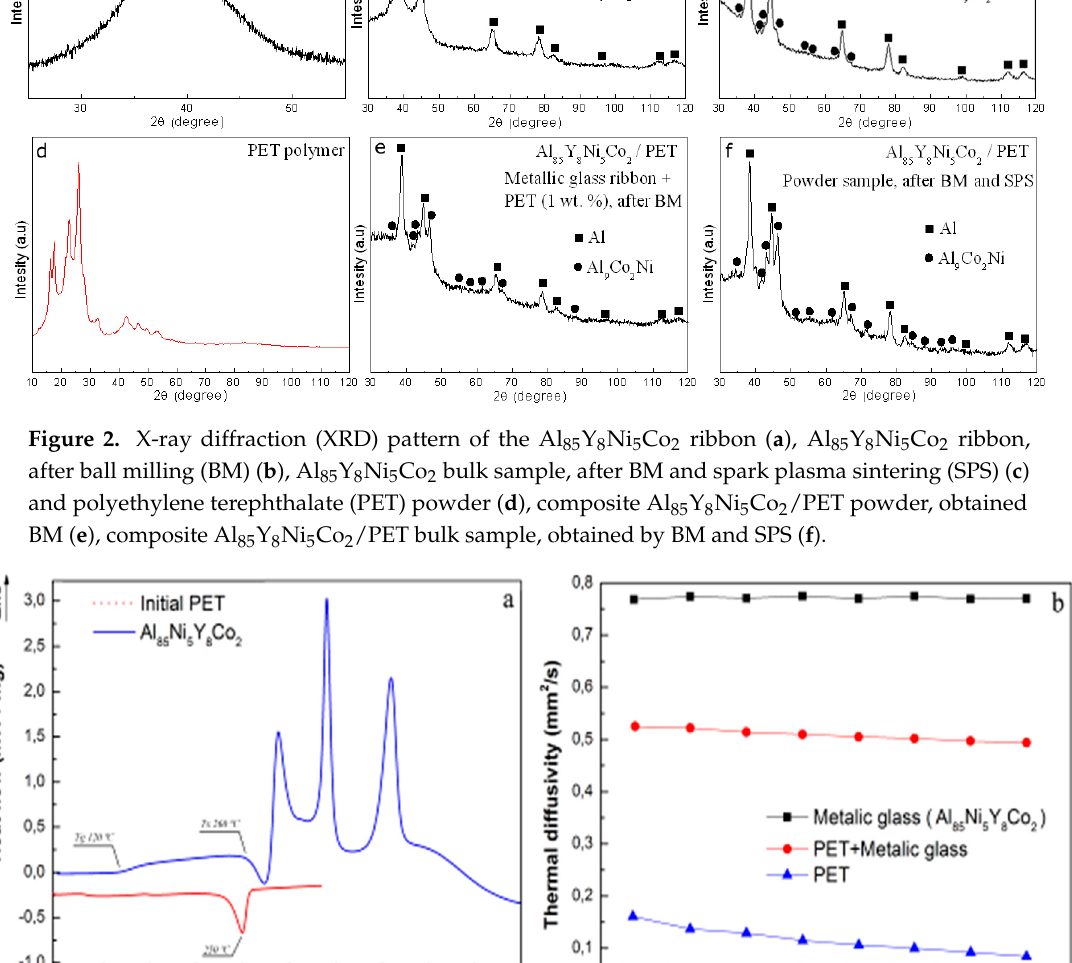
Figure 2. X ‐ ray diffraction (XRD) pattern of the Al 85 Y 8 Ni 5 Co 2 ribbon ( a ), Al 85 Y 8 Ni 5 Co 2 ribbon, after ball milling (BM) ( b ), Al 85 Y 8 Ni 5 Co 2 bulk sample, after BM and spark plasma sintering (SPS) ( c ) and polyethylene terephthalate (PET) powder ( d ), composite Al 85 Y 8 Ni 5 Co 2 /PET powder, obtained BM ( e ),